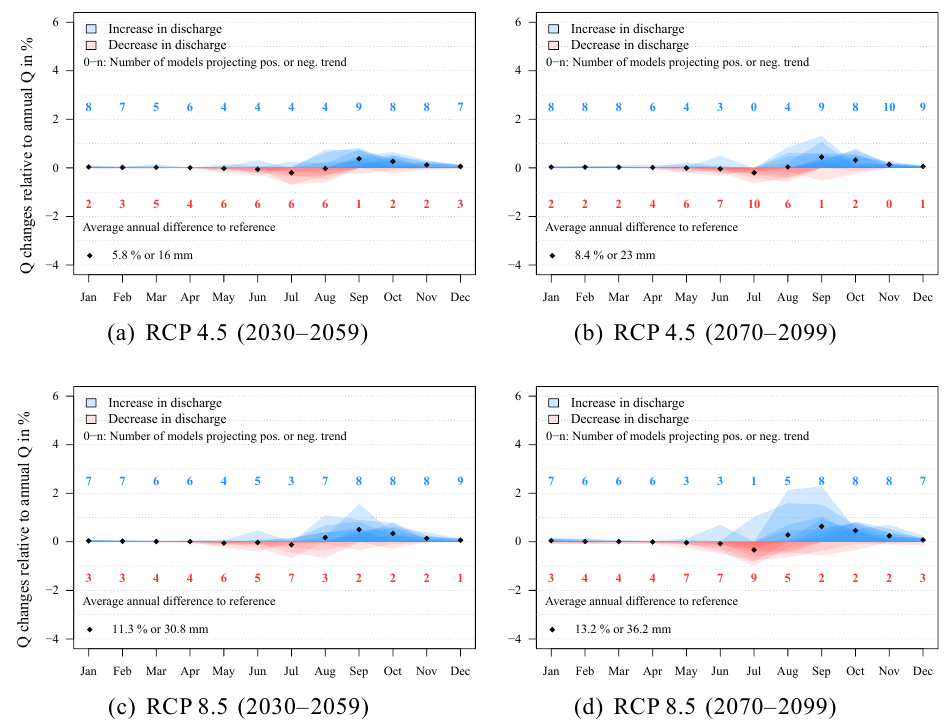
Figure 13. Monthly discharge changes of the selected model ensemble (10 models) relative to average annual discharge in the reference period (1970–1999) at gauge El